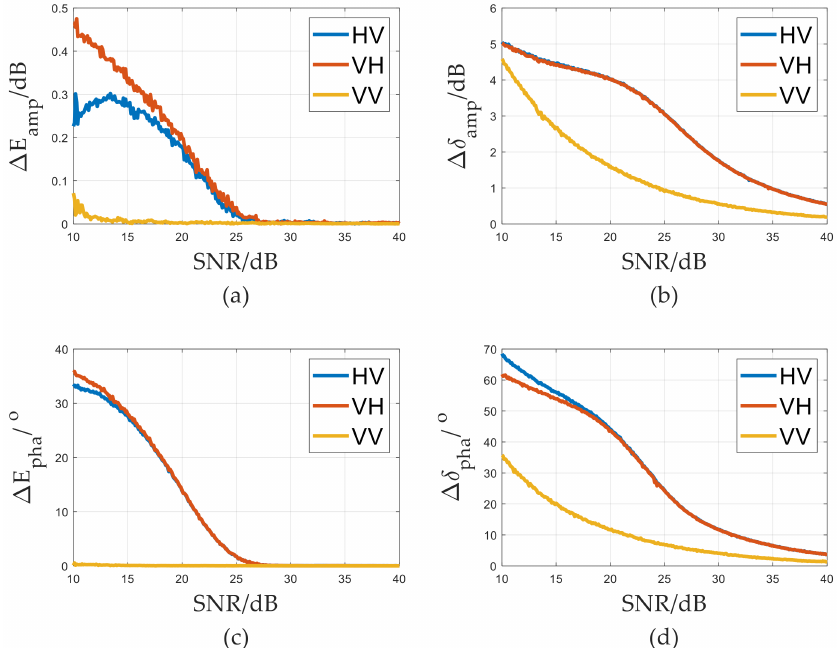
Figure 7. The differences of the expectation and standard deviation of the amplitude and phase errors of STCT and PCTAR at different SNRs and different polarization channels. ( a ) Differences of amplitude error expectation ∆ E amp ; ( b ) differences of standard deviation of amplitude error ∆ δ ∆ E amp ; ( c ) differences of phase error expectation pha ; ( d ) differences of standard deviation of phase error ∆ δ pha